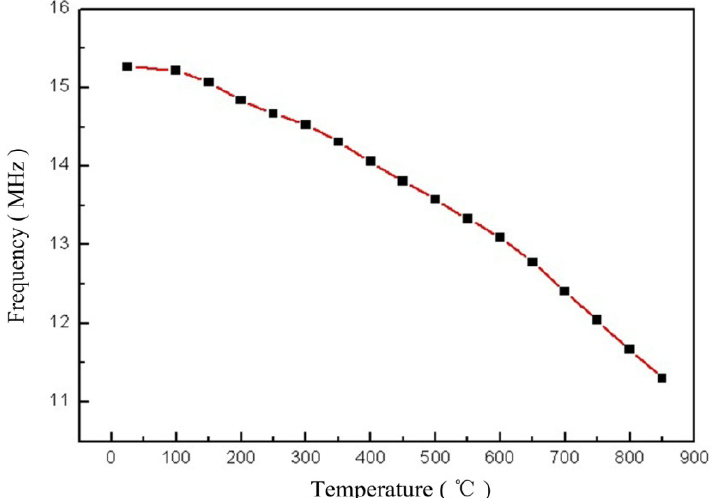
Figure 8. The resonant frequency of the sensor versus temperature.